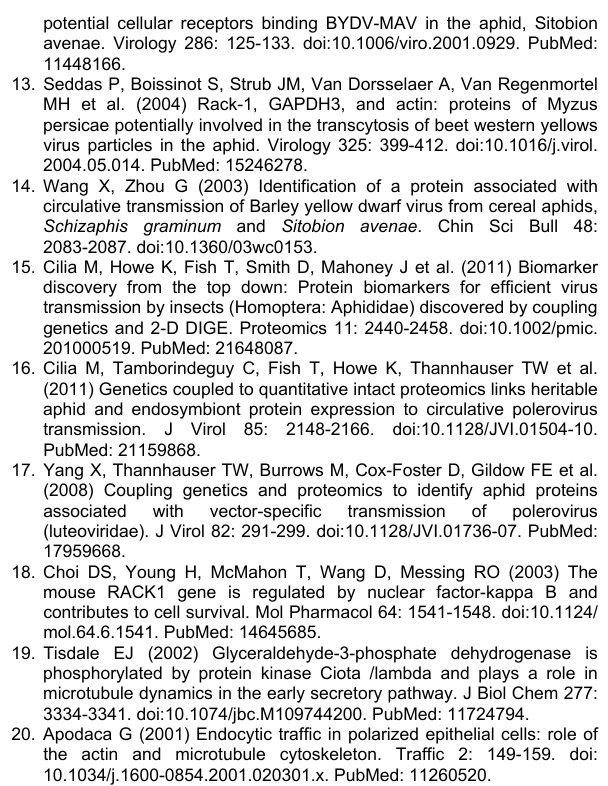
Figure S1. Translation of contig from 454 sequencing of Biotype H cDNA head and gut library containing the cyclophilin A gene sequence. Translation of S. graminum cyclophilin A from a 454-generated cDNA sequence database that was identified in a co-IP reaction using aphid proteins and purified CYDV-RPV. Figure S2. Sequence alignment of the 5 cyclophilin alleles identified. CV: allele encoding the vector isoform. CNV1-4: alleles encoding the nonvector isoform. Boxes show the nucleotide differences among alleles. * shows the unique nonsynonymous change in position 94. CV and CNV1 represent the alleles identified in the vector and nonvector parent, respectively.